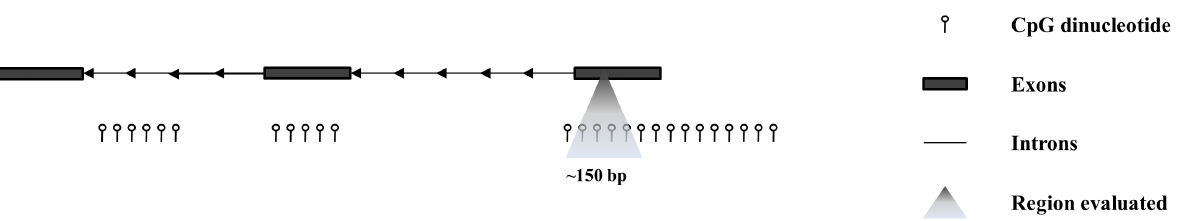
Figure 1. CpG islands described on CDKN2A gene. Three studies evaluated the same CpG island in an amplicon with 150 bases pair